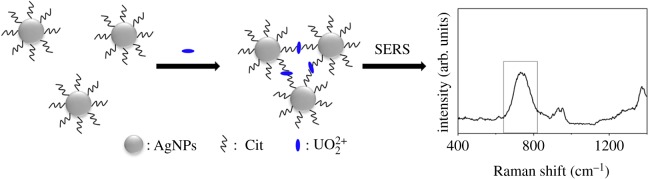
Schematic of the citrate-stabilized AgNPs for SERS detection of UO22+.